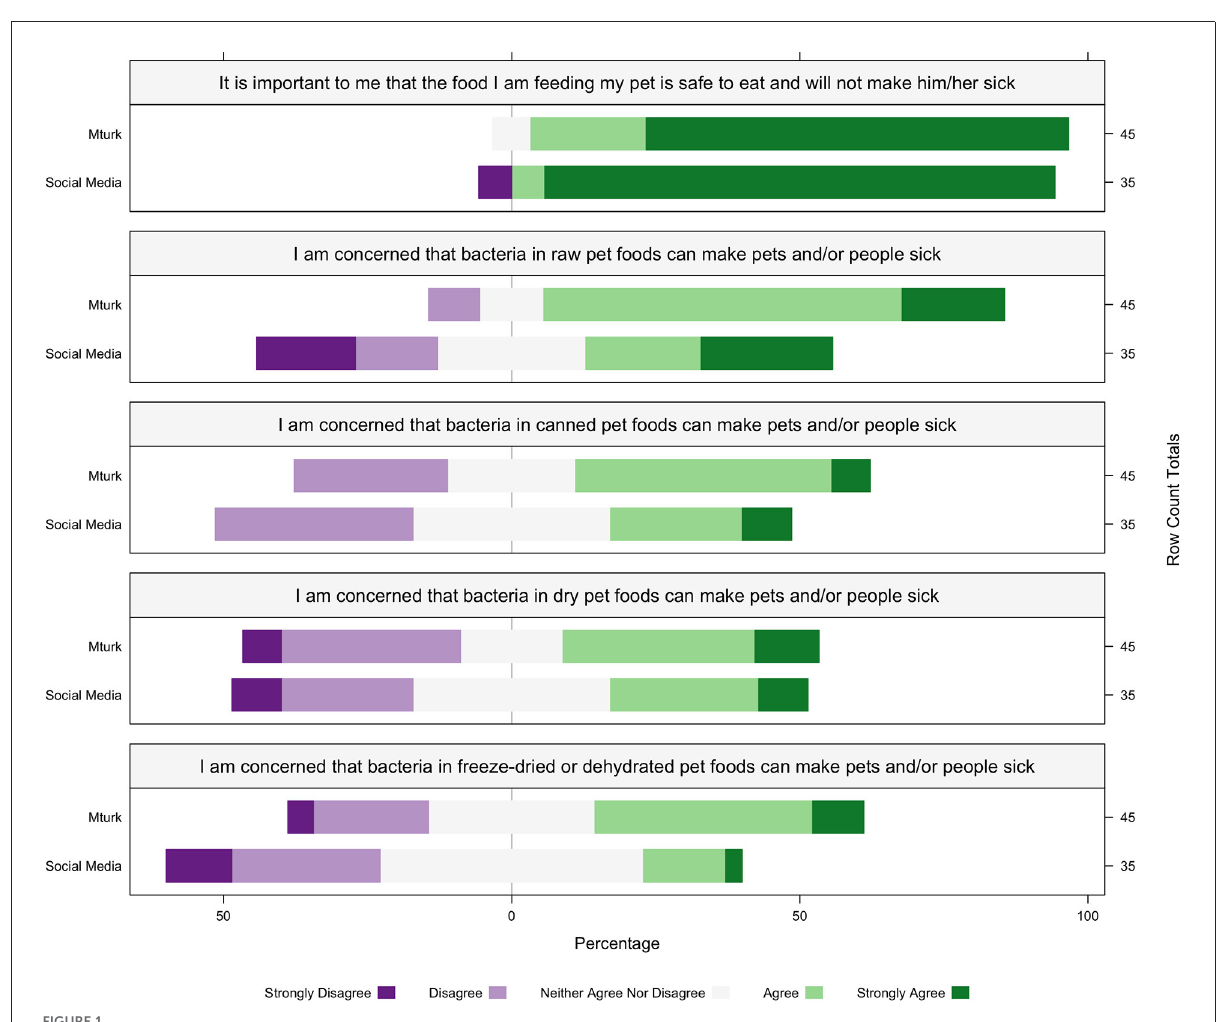
FIGURE1 The percentage within each recruitment source of MTurk (MT; n = 45) and social media (SM; n = 35) of consumer agreement with pet food safety concerns. Participants reported to “Strongly Disagree,”. “Disagree,” “Neither agree Nor Disagree,” “Agree,” or “Strongly Agree” to each pet food safety concern listed in the box above each corresponding plot. The percentage of participants within each recruitment source is represented on the x-axis, the recruitment source is represented on the left y-axis, and the row count totals (the number of participants for each question within each recruitment source) are listed on the right y-axis for each